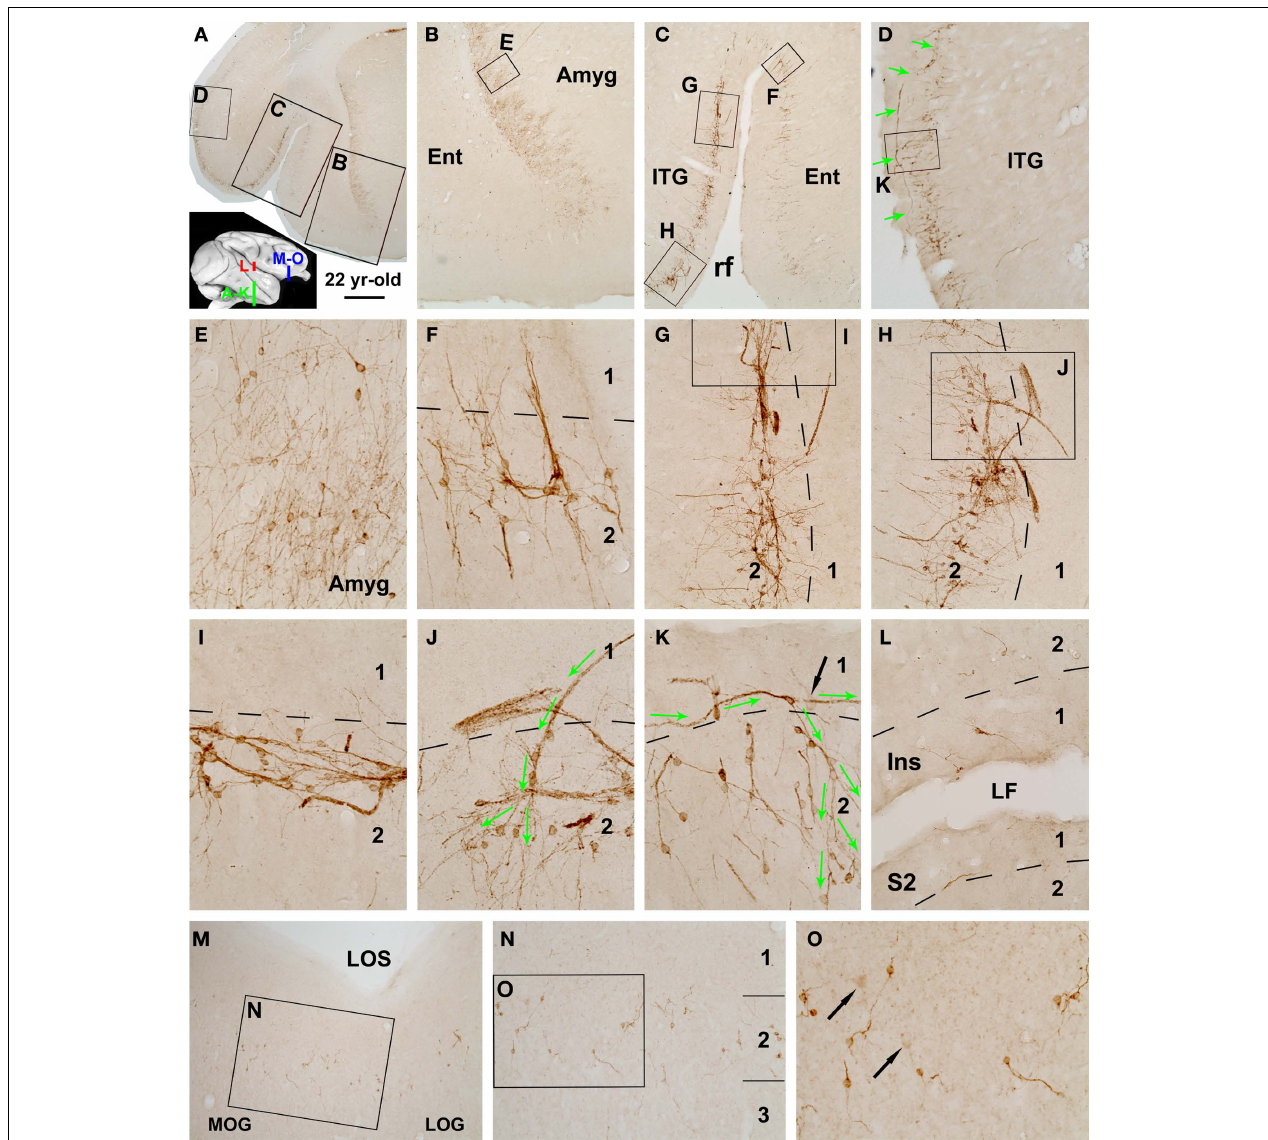
FIGURE 2 | Distribution of DCX + cells in the temporal lobe cortical areas surrounding the amygdala (A–K), in the insular (Ins) and secondary somatosensory (S2) cortex (L), and in the ventral prefrontal cortex including the medial and lateral orbital gyri (MOG, LOG) (M–O) in a 22-year-old rhesus monkey. Framed areas in lower magnifi cation panels are enlarged sequentially as indicated. DCX + cells in the amygdala (Amyg) are located near the white matter deep to the entorhinal cortex (Ent) as a cellular band, which continues into the adjoining Ent and further dorsally into the inferior temporal gyrus (ITG) around the border of layers I and II (A–C) . Labeled cells are mostly small and bipolar, often arrange as clusters and chains with cells seemingly migrate outside-in